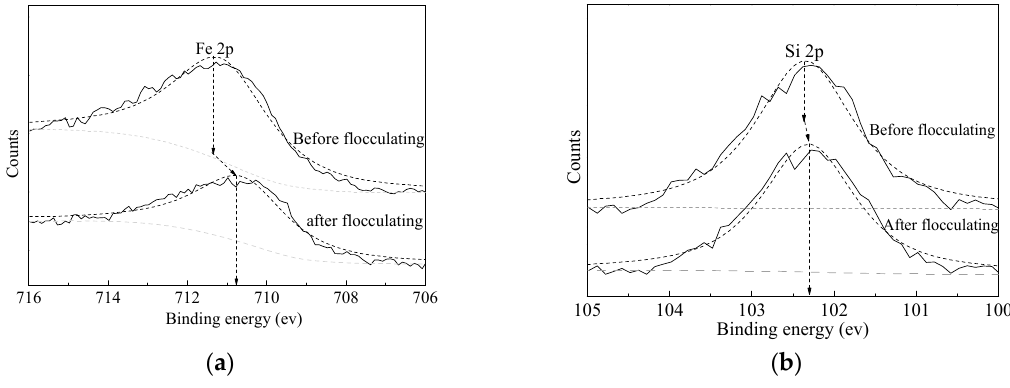
Figure 14. Fe 2p3/2 and XPS spectrum before and after flocculation. ( a ) Fe 3 O 4 ; ( b ) SiO 2 .